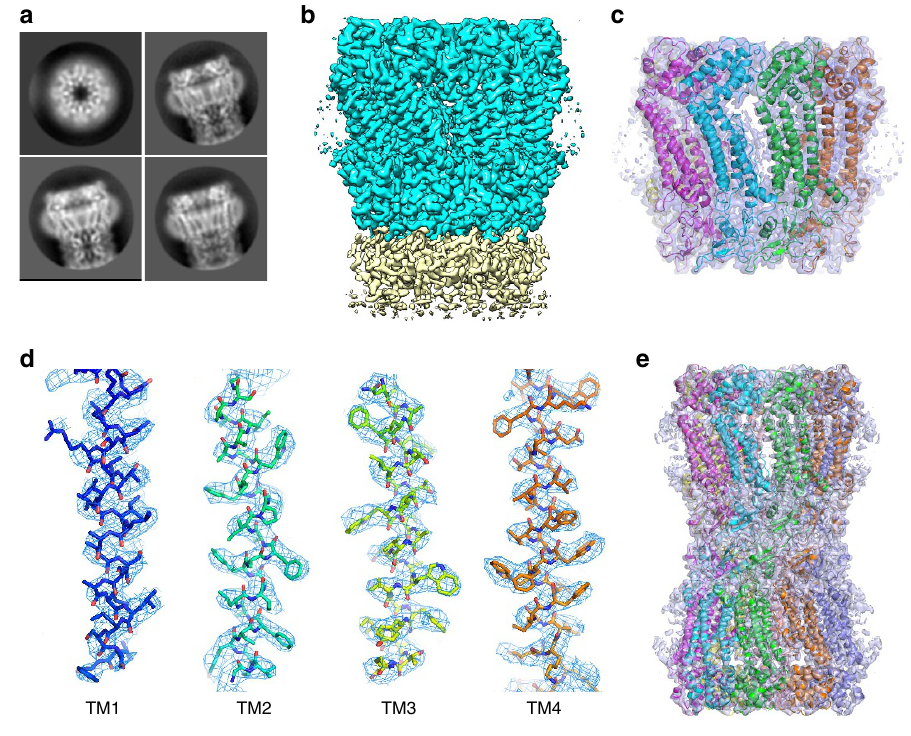
Figure 1 | Density maps of INX-6 determined by cryo-EM. ( a ) Representative two-dimensional class averages of INX-6 in top and side views. ( b ) Three-dimensional structure of INX-6 hemichannel (cyan) in a side view. Densities in yellow represent a part of the opposed hemichannel. ( c ) Ribbon style model of INX-6 superimposed on the density map of a hemichannel. ( d ) Density maps of transmembrane helices. Stick style atomic models of TM1-TM4 fit to the cryo-EM density maps (blue mesh). The density map is contoured at 2.0 s . ( e ) Ribbon style model of INX-6 fit on the density map of a gap junction